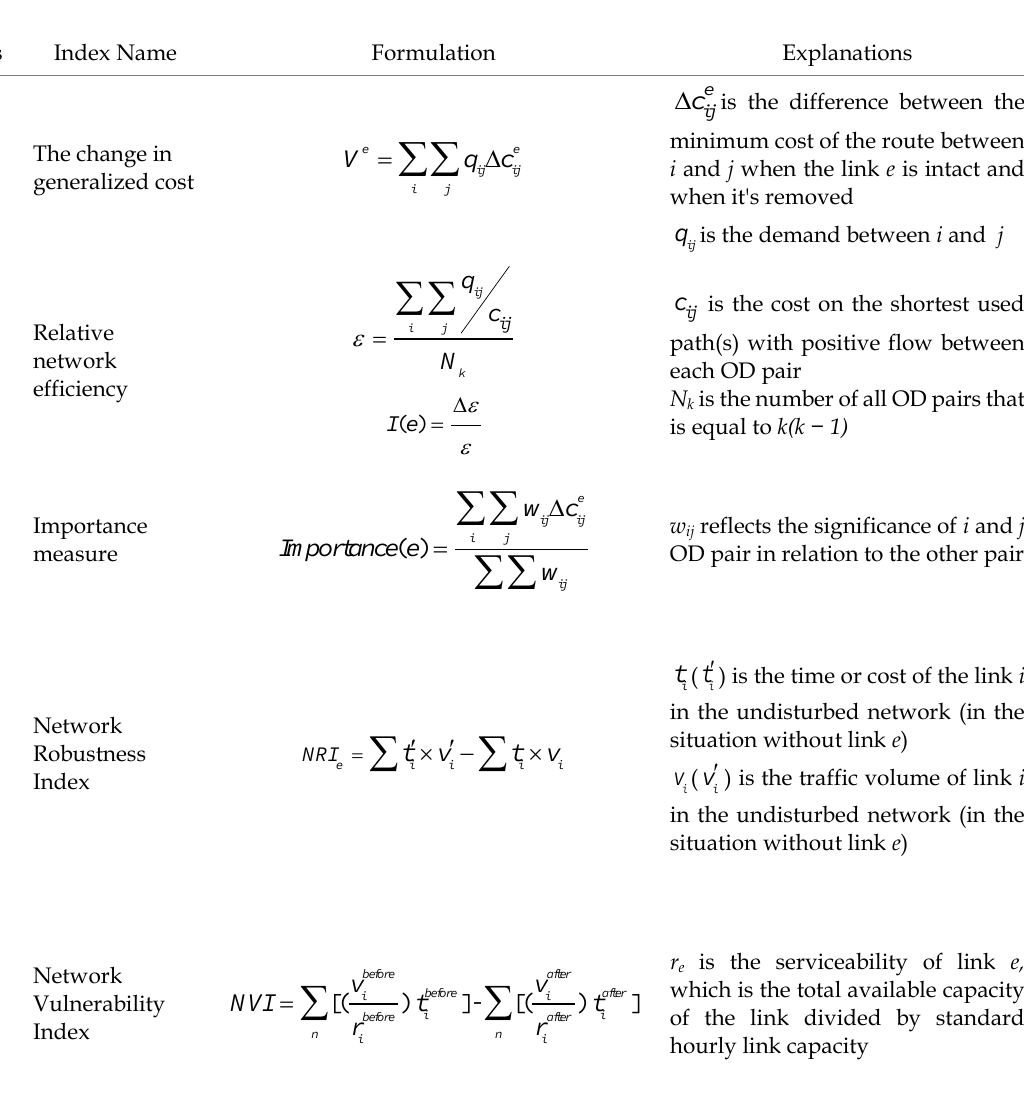
Summary of system-based vulnerability assessment